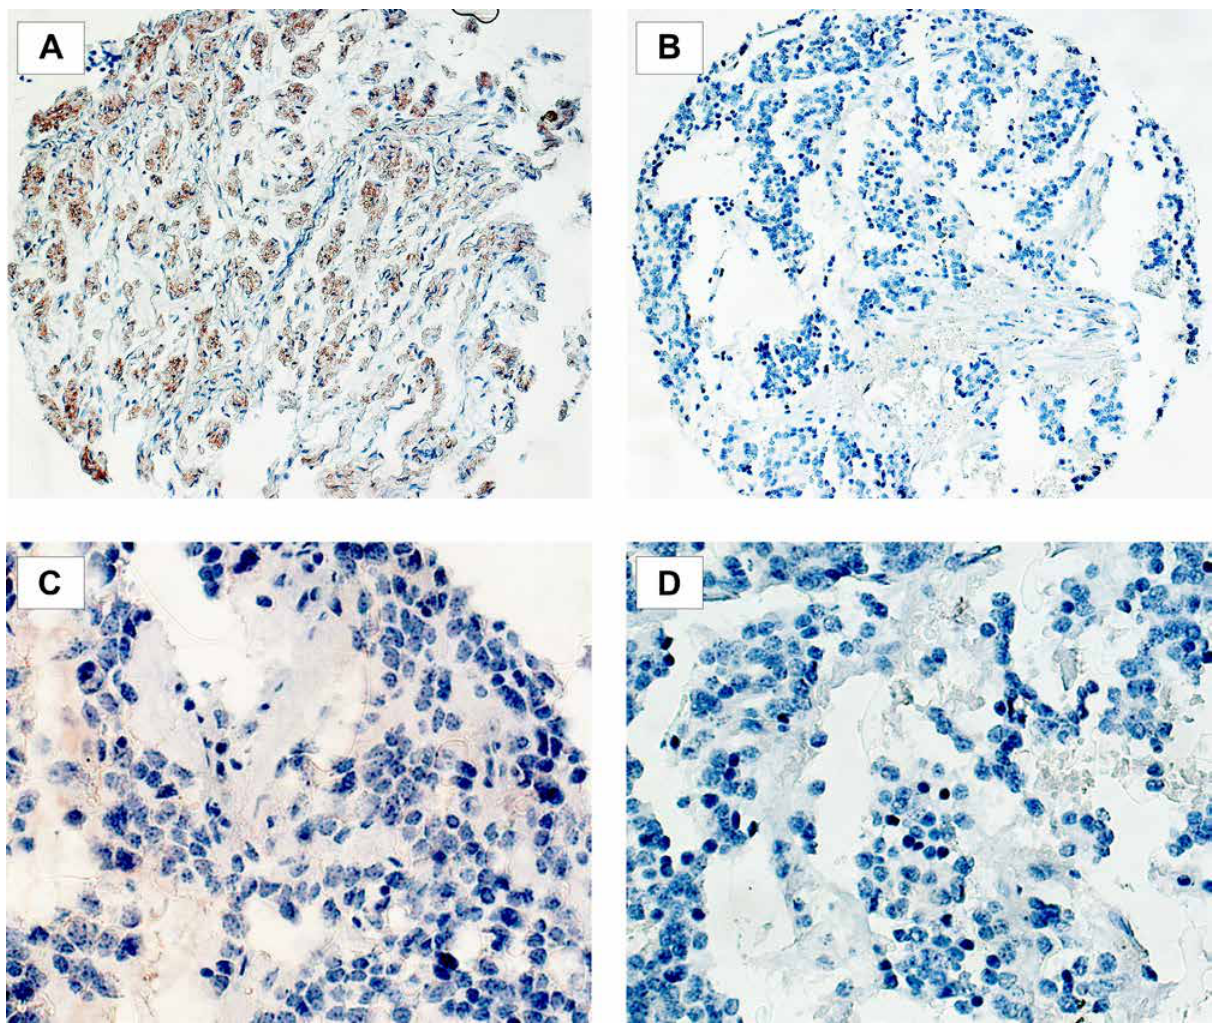
Figure 1: Expression of CHL1 and NrCAM in pediatric neuroblastoma. Representative examples of CHL1 positive (A) and CHL-1 negative (B) (magnification x100) as well as NrCAM positive (C) and NrCAM negative (D) immunostaining (magnification